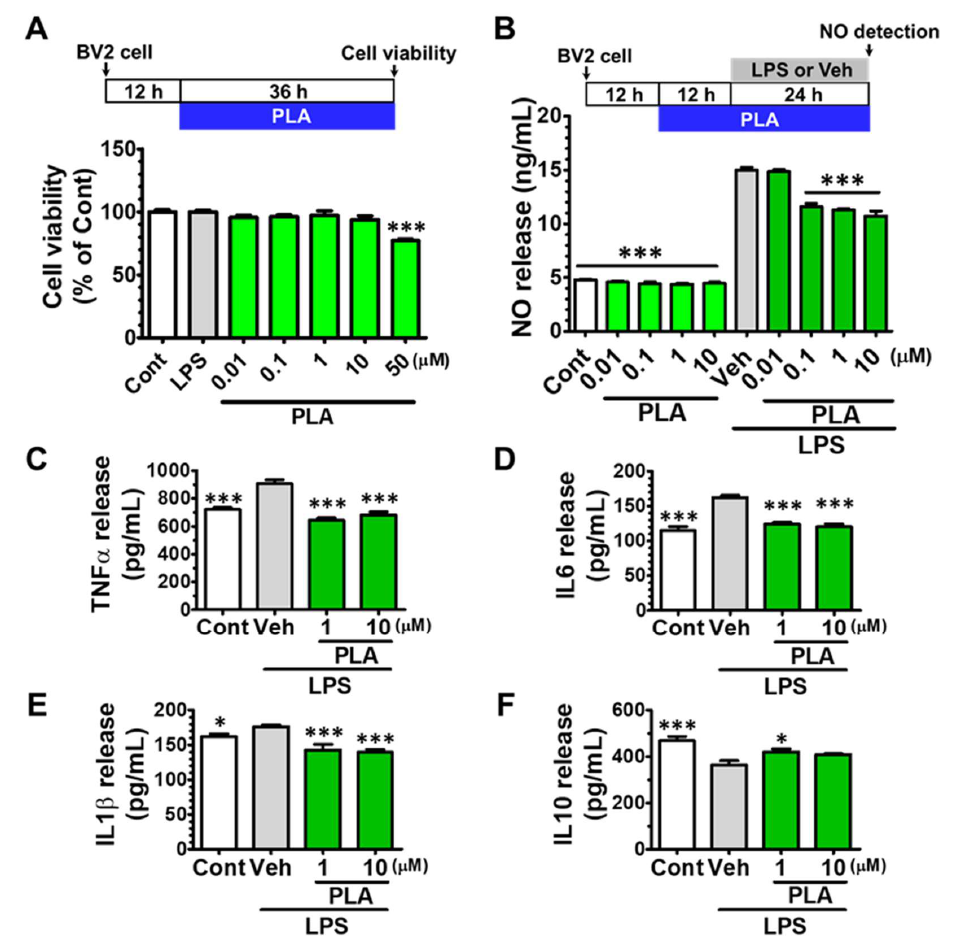
Figure 1. Effects of platycodigenin (PLA) on Lipopolysaccharide (LPS)-induced NO and pro-inflammatory cytokines production in BV2 microglia. BV2 microglia were seeded in 96-well plates for 12 h, followed by treatment with PLA for 36 h ( A ) and the cell viability was assayed. BV2 microglia (2 × 105 cells / mL) were seeded in 48-well plates for 12 h, followed by pretreatment with PLA for 12 h and then LPS (100 ng / mL) was stimulated for another 24 h. NO release ( B ) was detected by Griess reagent method and concentrations of TNF- α ( C ), IL-6 ( D ), IL-1 β ( E ) and IL-10 ( F ) were determined by ELISA kit. The data are shown as the mean ± SEM of three independent experiments. Each group has five replicates in the independent experiment. * p < 0.05, and *** p < 0.001 versus vehicle (Veh), Kruskal-Wallis one-way analysis of variance by ranks test and one-way analysis of variance and Dunnett’s post hoc